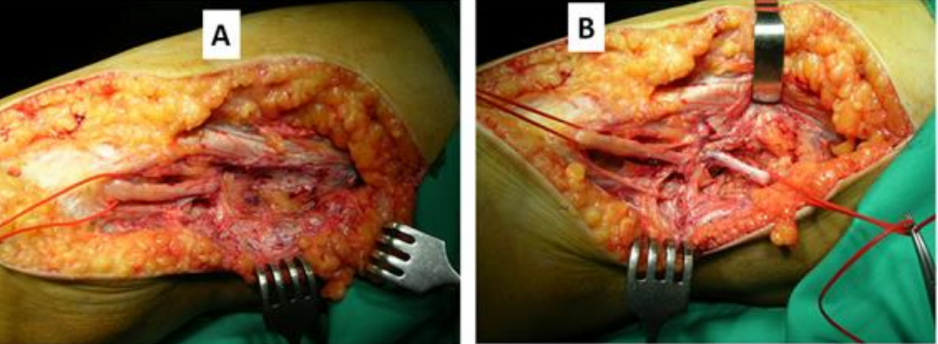
Figure 3. ( A ) Intraoperative image of fibrosis encompassing the EPSN. ( B ) Intraoperative image of the NPCE after neurolysis; note the macroscopic appearance of the nerve in its compressed